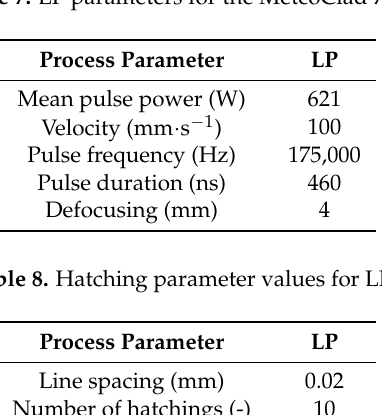
Table 7. LP parameters for the MetcoClad 718.